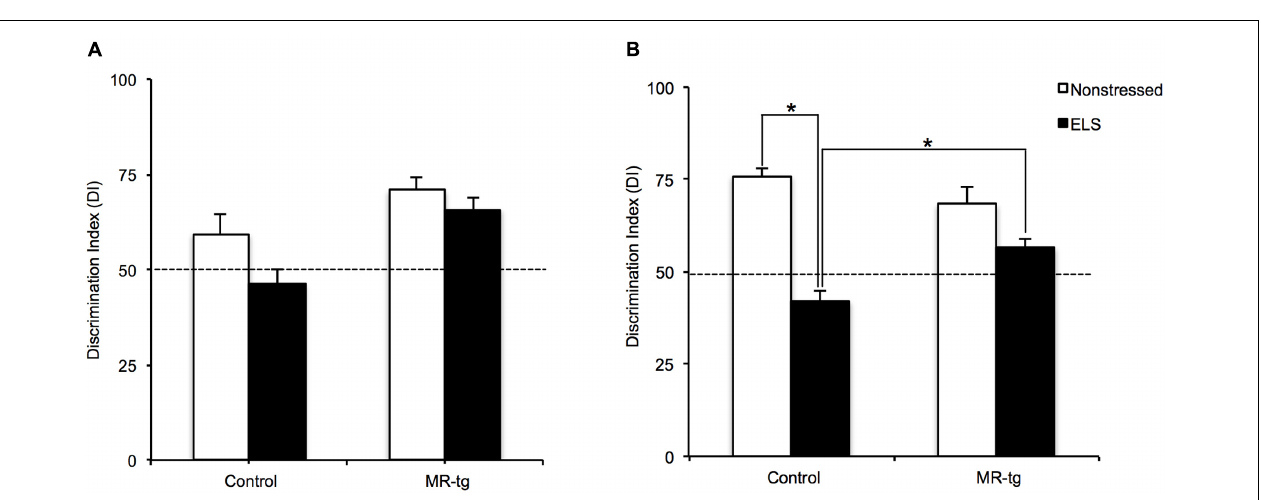
FIGURE 2 | Recognition memory in MR-tg and control mice. The discrimination index as observed in mice tested in (A) the object in-context task and (B) in object relocation task. Data are expressed as mean ± SEM with p -values based on post hoc LSD. n = 10–12 mice per group. ∗ Significant, p ≤